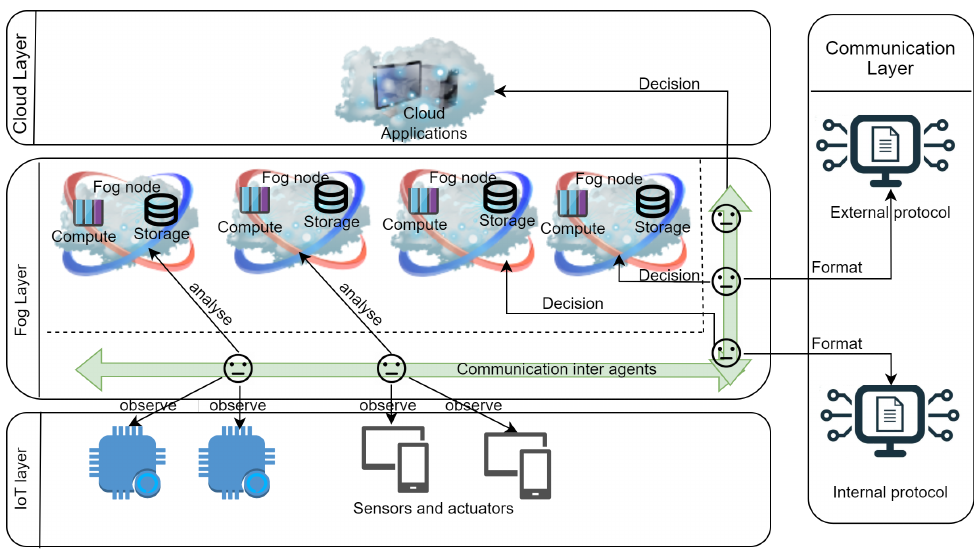
Figure 2. Cross-layered architecture for fog systems (CLA 4